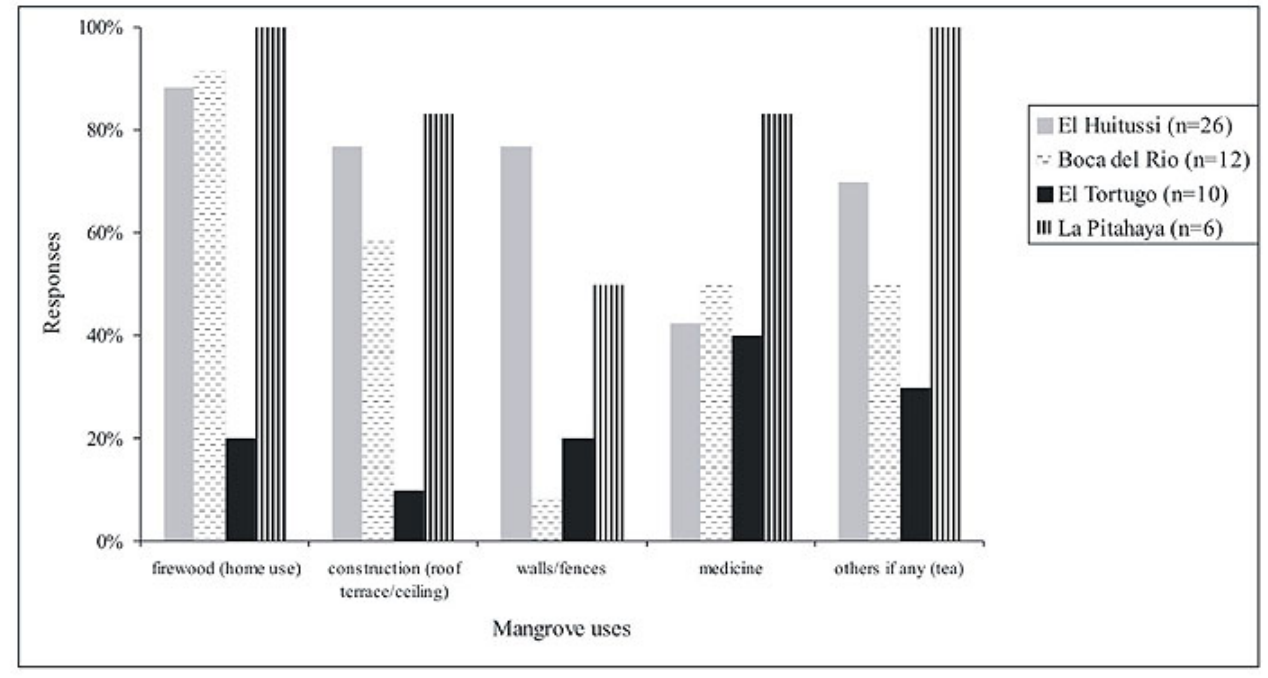
Fig. 2. Different uses of mangrove by local villagers from La Pitahaya, Boca del Río, El Tortugo, and El Huitussi villages (Sinaloa,